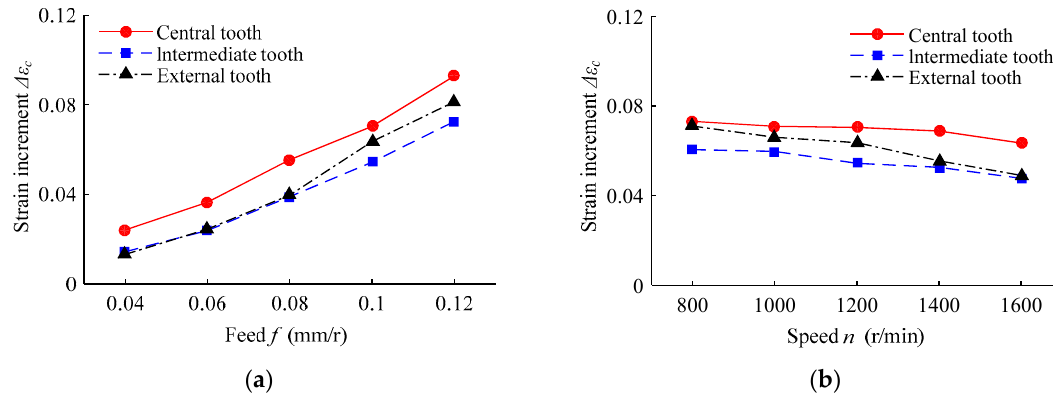
Figure 15. Effect of the drilling process parameters on the chip strain increment: ( a ) under different drilling feeds at a speed of 1200 r/min; ( b ) under different drilling speeds at a feed of 0.1 mm/r.